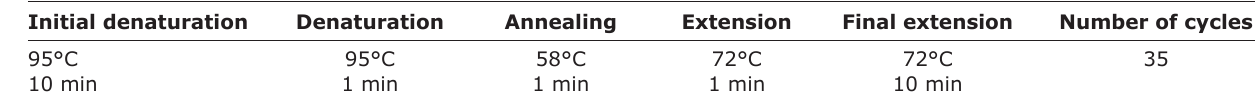
Table-2: PCR cycling conditions. Initial denaturation